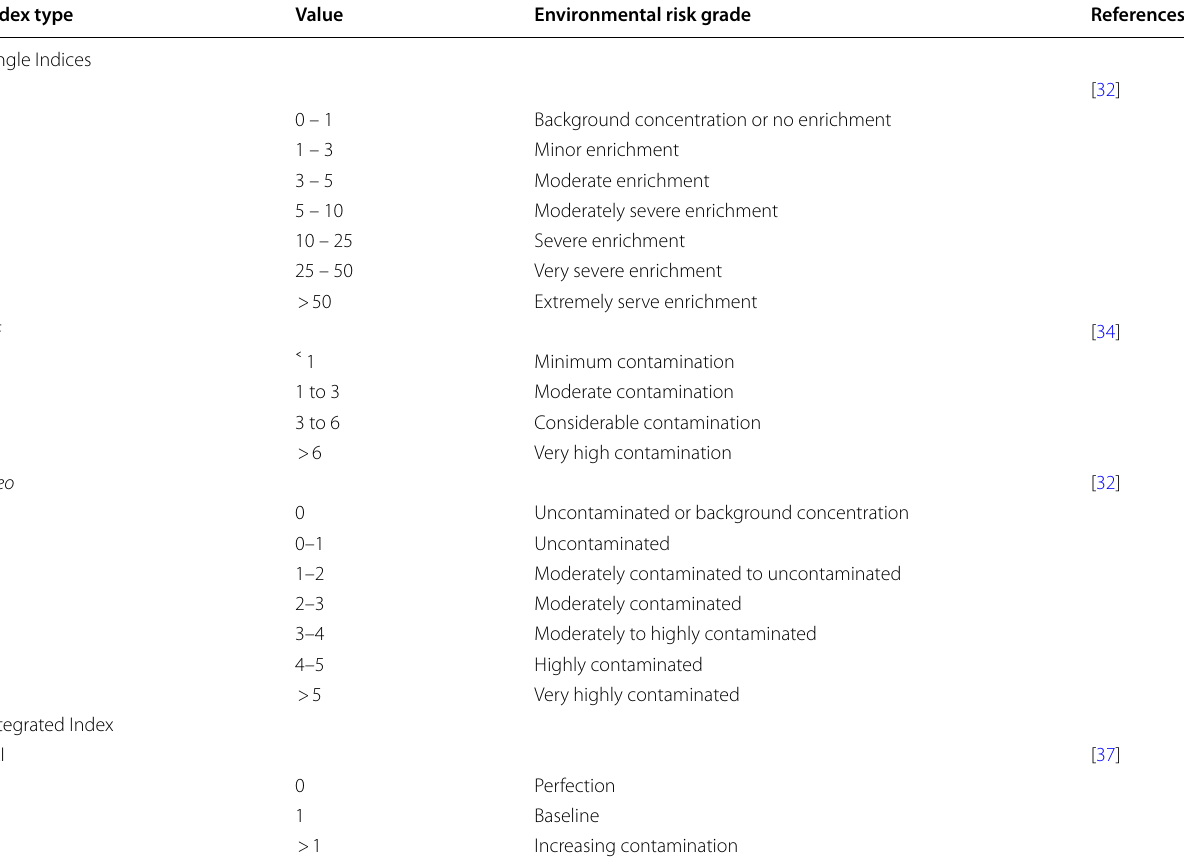
Table 4 Enriched factor (EF), contamination factor (CF), geo-accumulation index (Igeo) and pollution load index (PLI) range values and their environmental risk